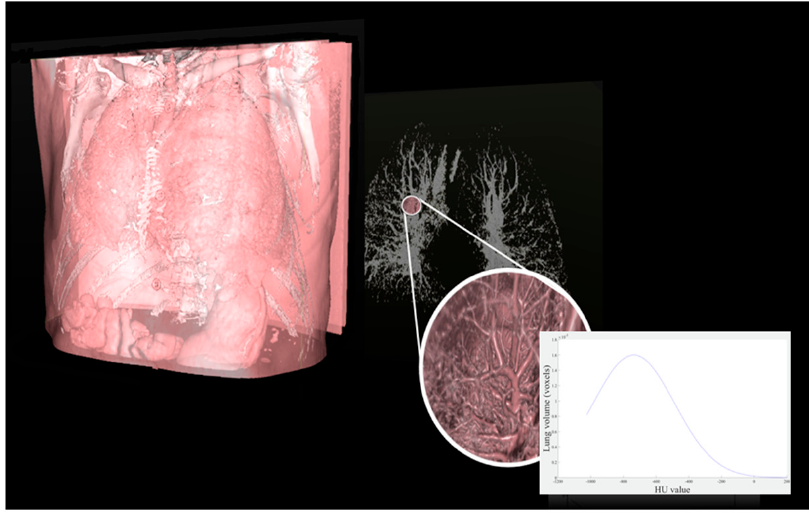
Figure 1. Representative high-resolution computed tomography (HRCT) study and extraction of lung histogram to obtain quantitative parameters.